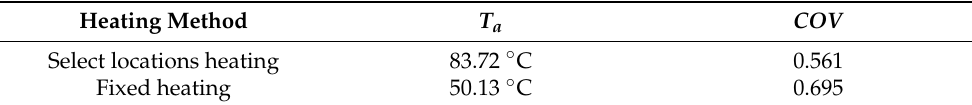
Table 6. T a and COV after heating at select locations (material: beef).